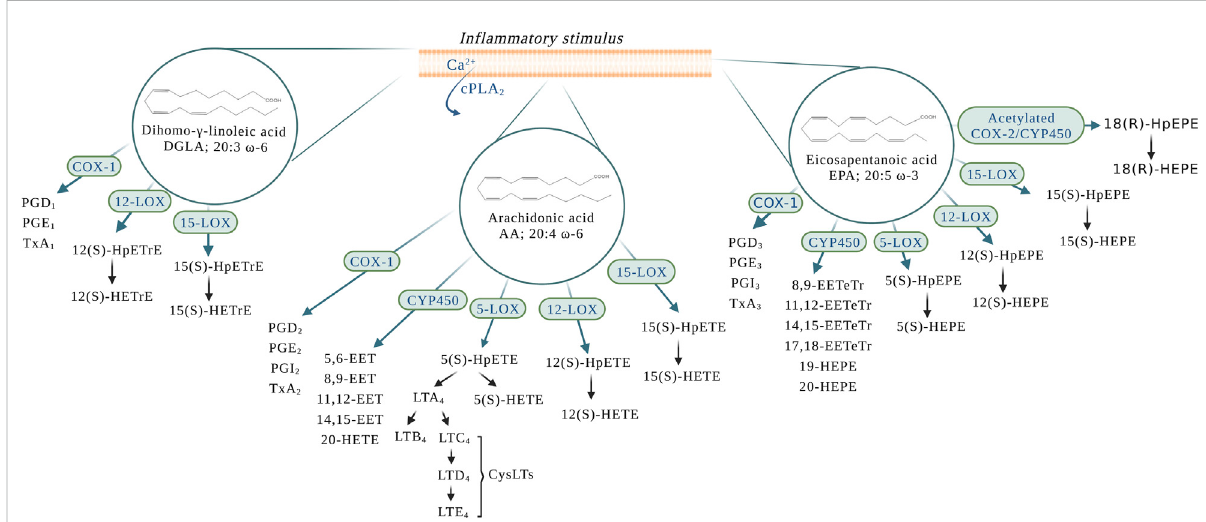
FIGURE 1 Eicosanoid biosynthesis in the blood and the vessel upon an in fl ammatory stimulus. AA : arachidonic acid; COX-1 : cyclooxygenase-1; COX-2 : cyclooxygenase-2; cPLA 2 :cytoplasmicphospholipaseA 2 ; CYP450: P450cytochromeepoxygenase; CysLTs: cysteinylleukotrienes; DGLA :dihomo- γ -linolenic acid; EPA : eicosapentaenoic acid; LTA 4 : leukotriene A leukotrieneE 4 ; PGD 1 :prostaglandinD 1 ; PGD 2 :prostaglandinD 2 ; PGD 3 :prostaglandinD 3 ; PGE 1 :prostaglandinE 1 ; PGE 2 :prostaglandinE 2 ; PGE 3 :